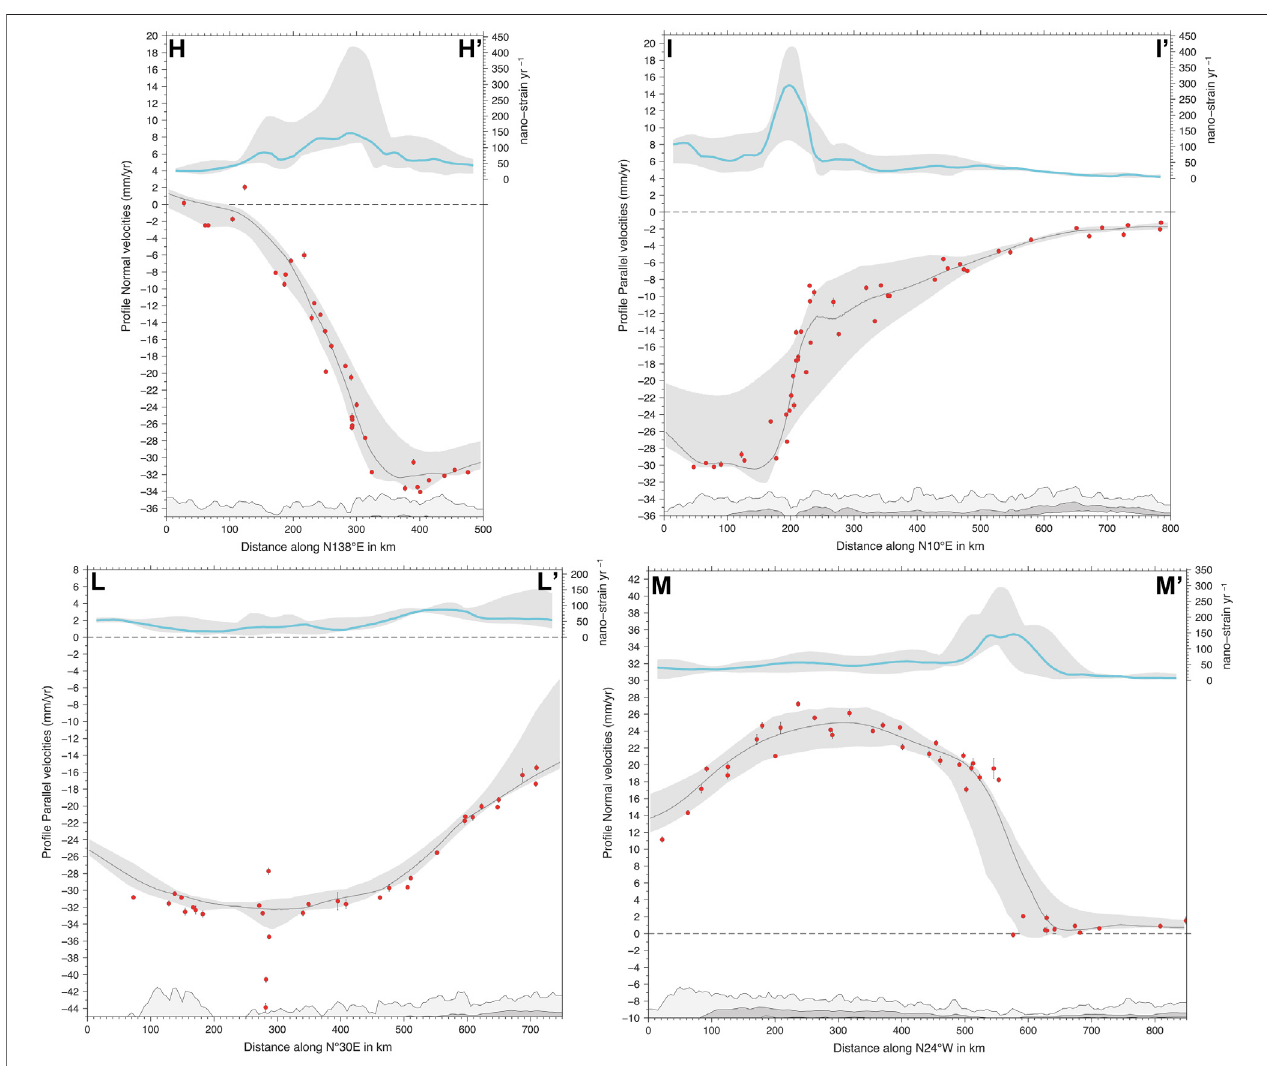
FIGURE 15 | Same as Figure 11 for pro fi les in the Eastern Mediterranean (see Figure 9 ) across the Ionian Islands and Khephalinia faults (H-H ’ ; pro fi le normal velocities plotted), the Corinth Gulf and Southern Balkans (I-I ’ ), Crete and the Aegean Sea (L-L ’ ) and across Anatolia (M-M ’ ; pro fi le normal velocities plotted).